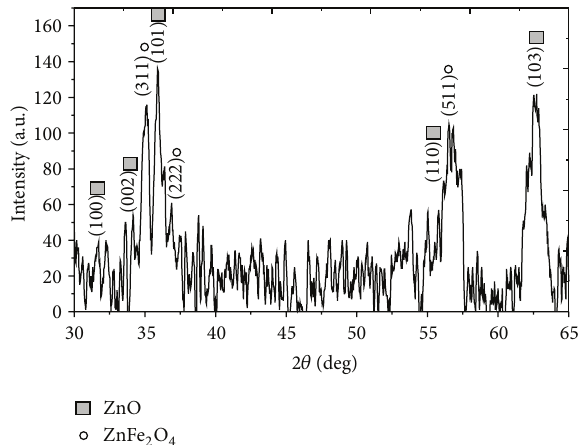
Figure 2: XRD pattern of ZnO NRs grown on stainless steel wire by CVD (650 ∘ C, 2 sccm O 2 , and 0.3g Zn